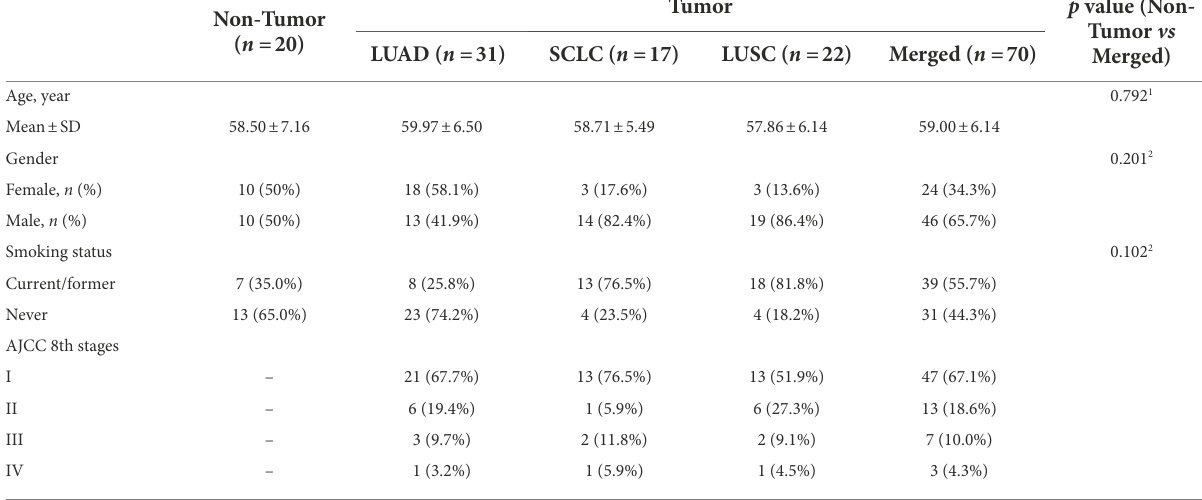
TABLE 1 Demographic and clinical characteristics of the